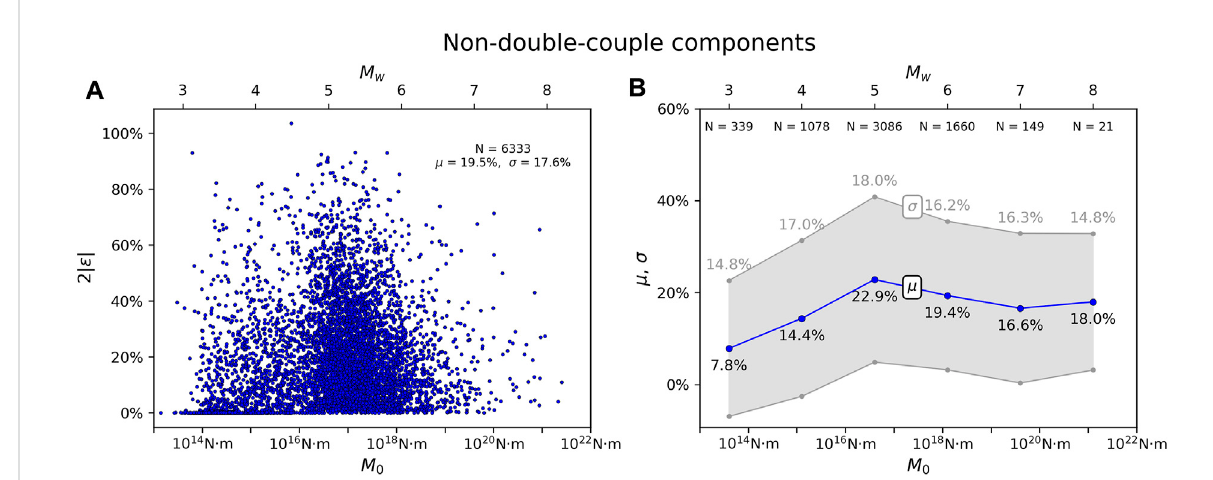
FIGURE 1 Distribution of non-double-couple components with magnitude in the USGS catalog. (A) The large number of earthquakes with no NDC components for M < 5, resulting from inversions which exclude them, causes an apparent increase of NDC components with magnitude until M 5 (B) , above which the average NDC component is essentially